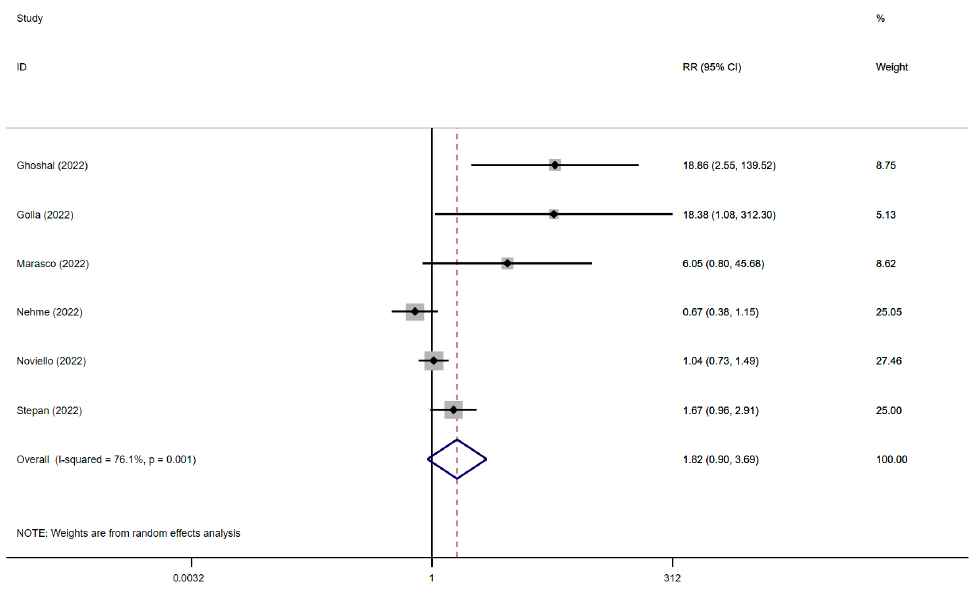
Figure 4. Forest plot of the association between IBS and SARS-CoV-2 infection [22,23,34–36,38]. IBS, irritable bowel syndrome; SARS-CoV-2, severe acute respiratory syndrome coronavirus 2; RR, risk ratio.